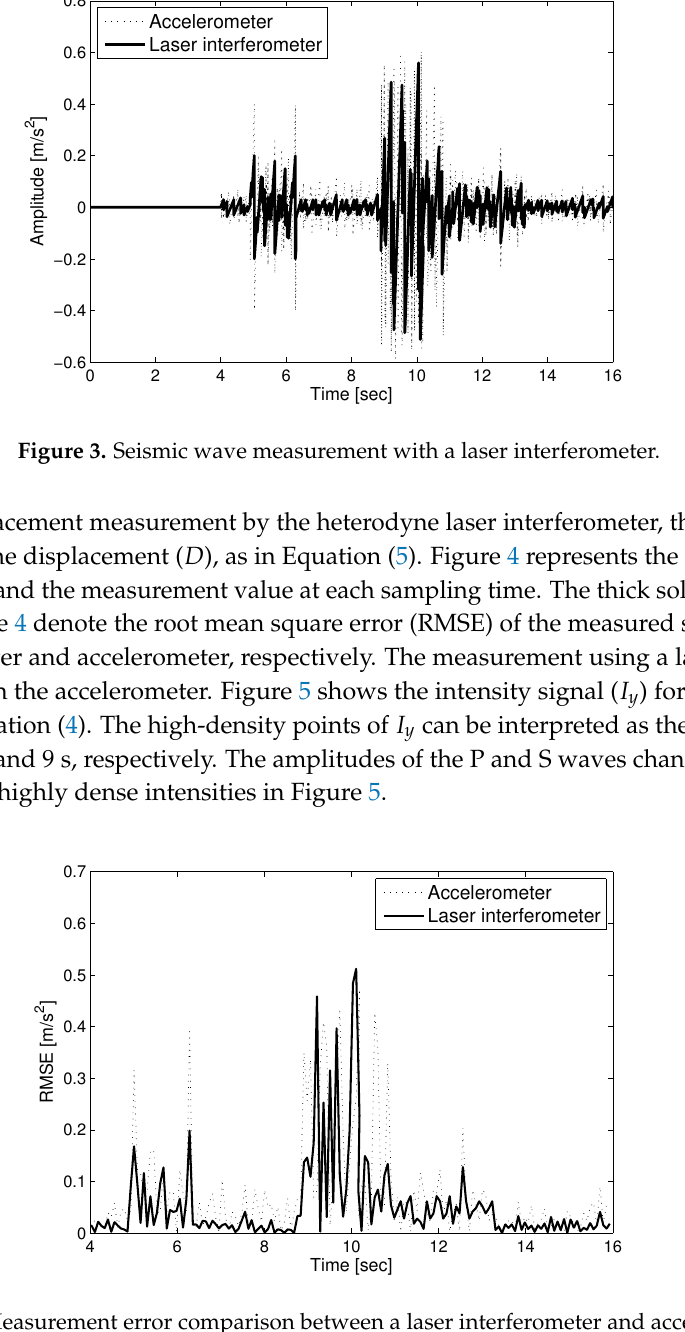
Figure 4. Measurement error comparison between a laser interferometer and